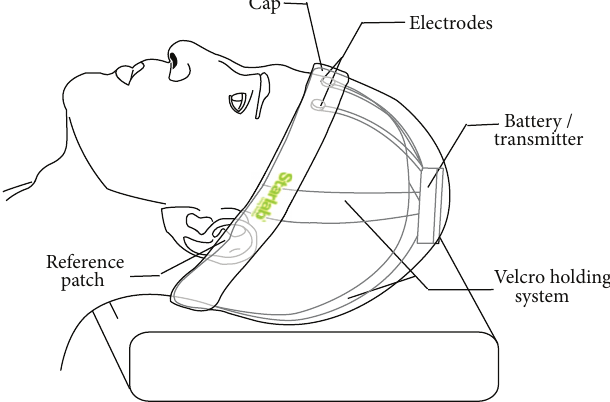
Figure 5: The modified cap was more comfortable during sleeping/going to